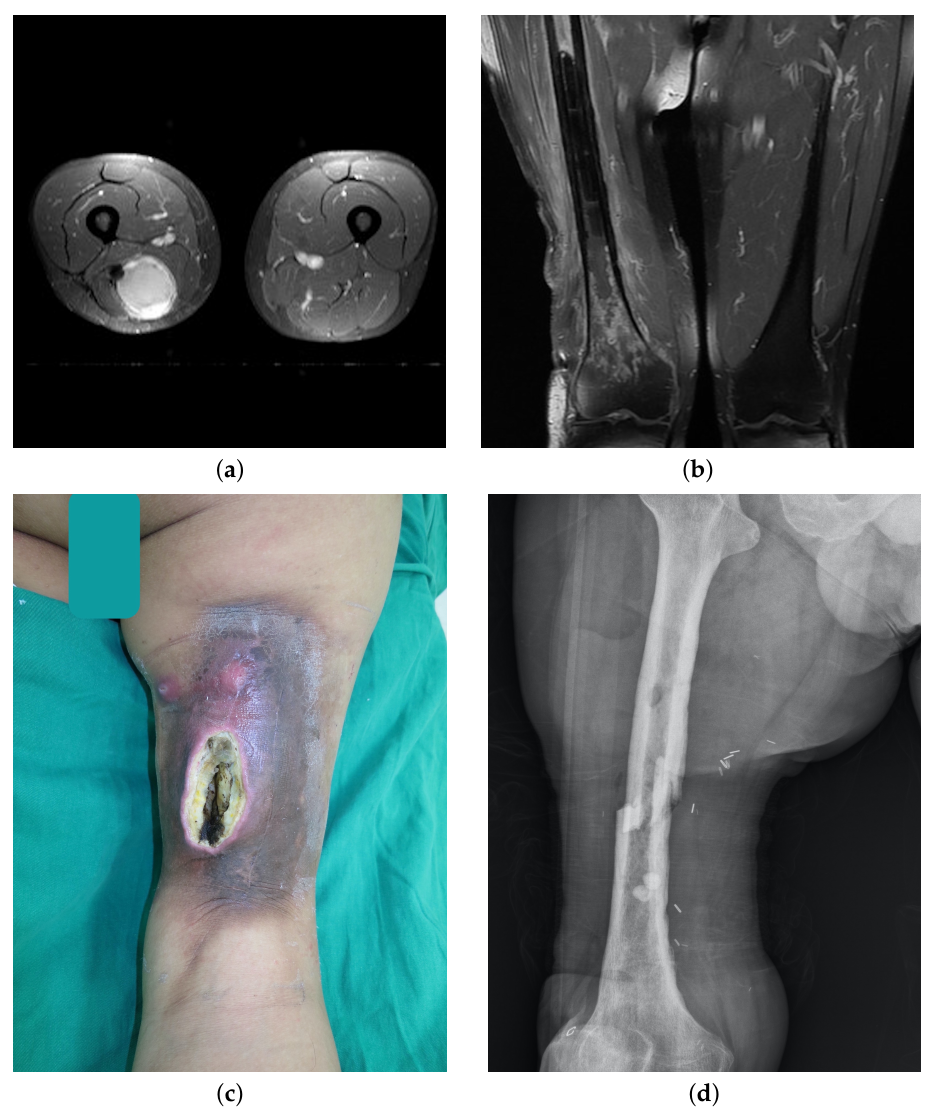
Figure 4. ( a ) Right posterior thigh intramuscular tumor, 4 × 5 × 6.9 cm 3 . ( b ) Right femur osteonecro- sis, fluid collection, and marrow replacement. (5 years after RT); ( c ) Full-thickness soft tissue necrosis with secondary infection and purulent discharge (3.5 years after RT); ( d ) pathological fracture of the right femoral shaft (5.5 years after